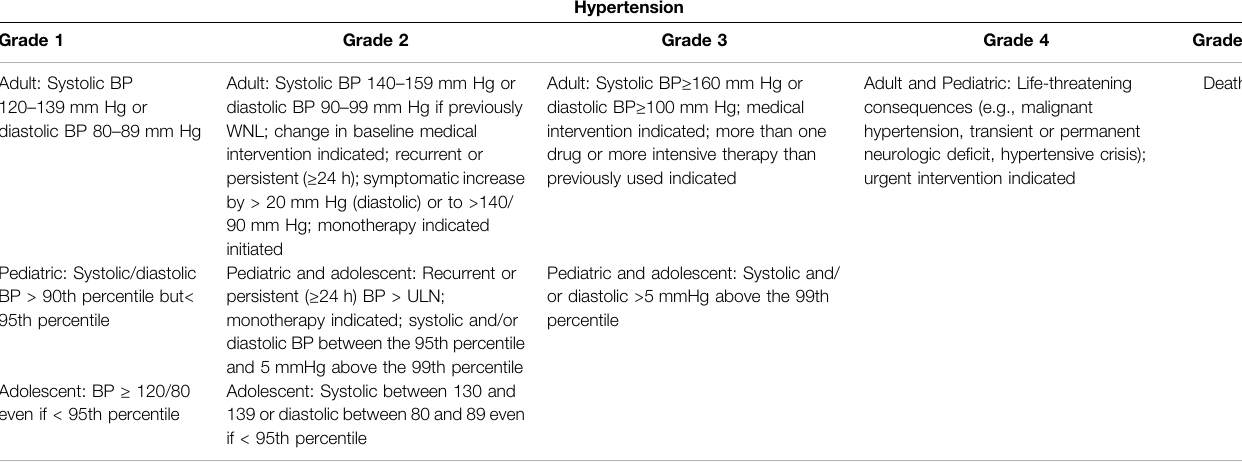
TABLE 2 | Characterized of hypertension in CTCAE.